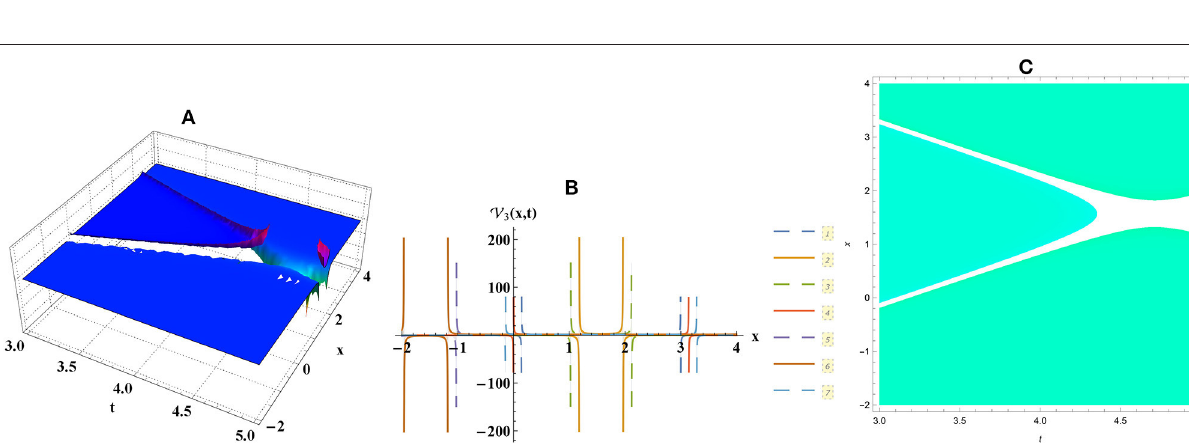
FIGURE 2 | Periodic numerical graph for Equation (6) through (A) three-dimensional, (B) two-dimensional, and (C) density plots.